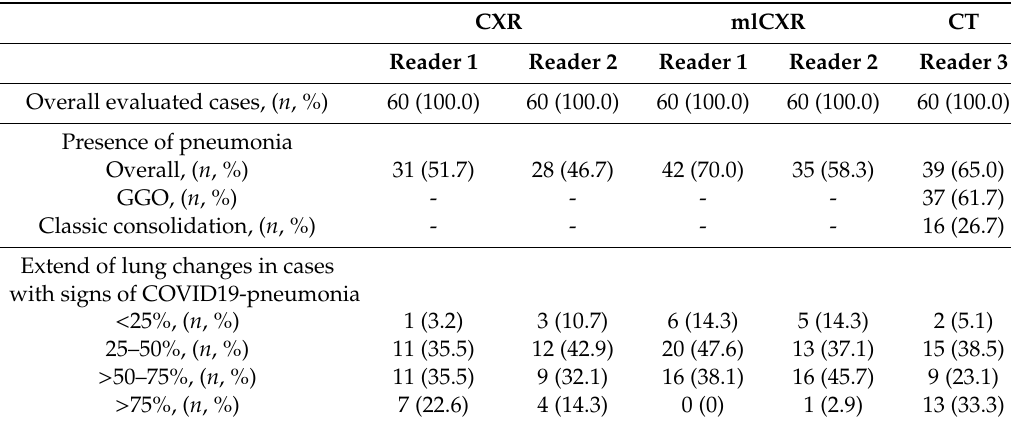
Table 2. Imaging findings.